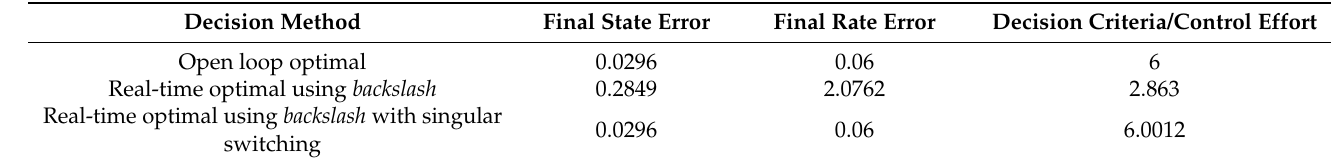
Table 3. Comparison of real-time optimal decision methods using backslash matrix inversion.